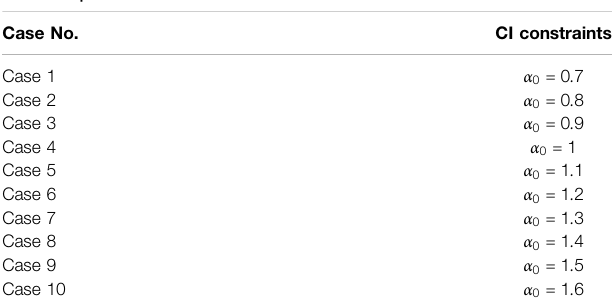
TABLE 6 | Ten cases with different